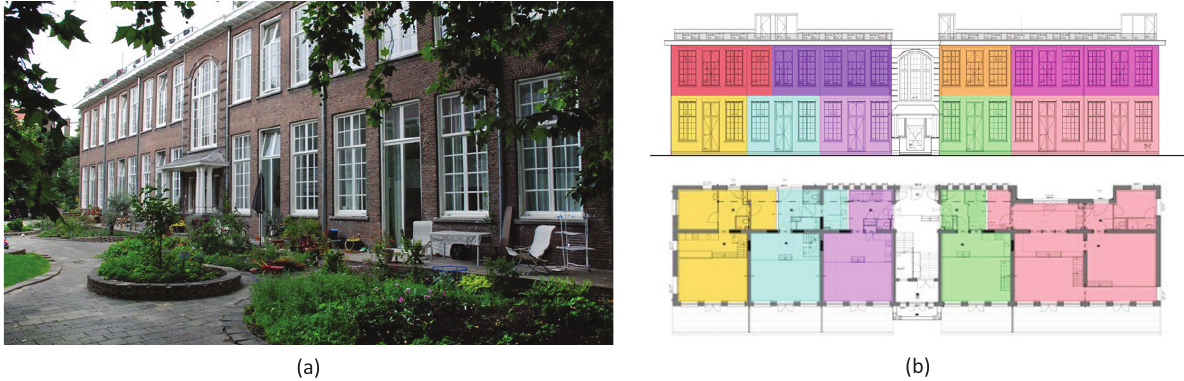
Figure 7. (a) School conversion, De Omscholing, Rotterdam. (b) Ground‐floor plan and facade showing the apartment com‐ position. Source: Courtesy of Gubu